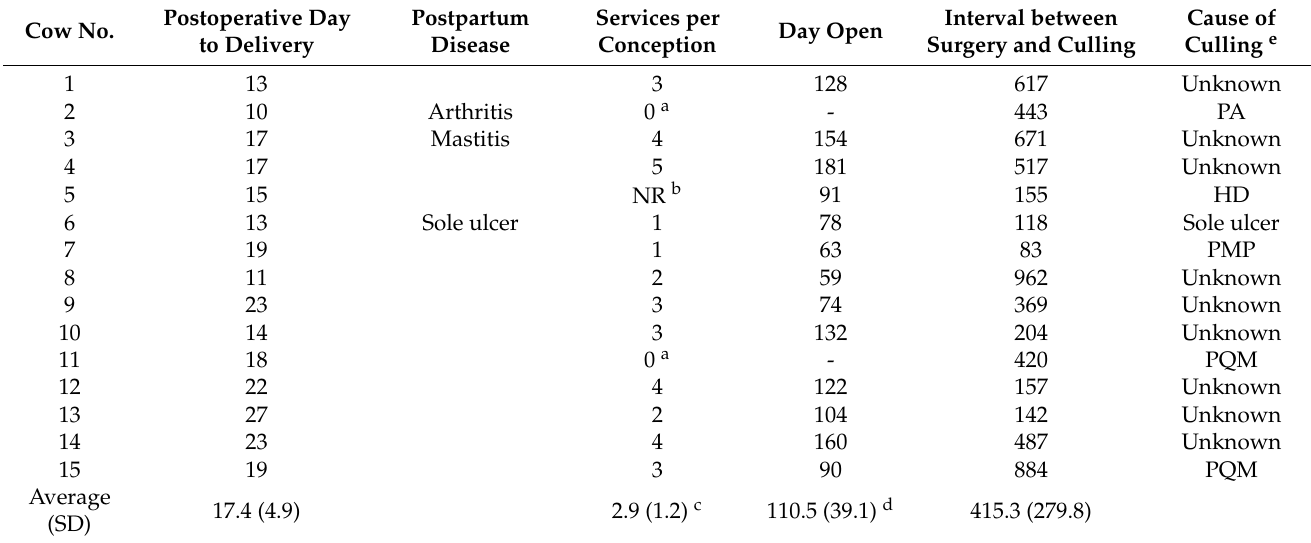
Table 2. Postoperative performance in the present